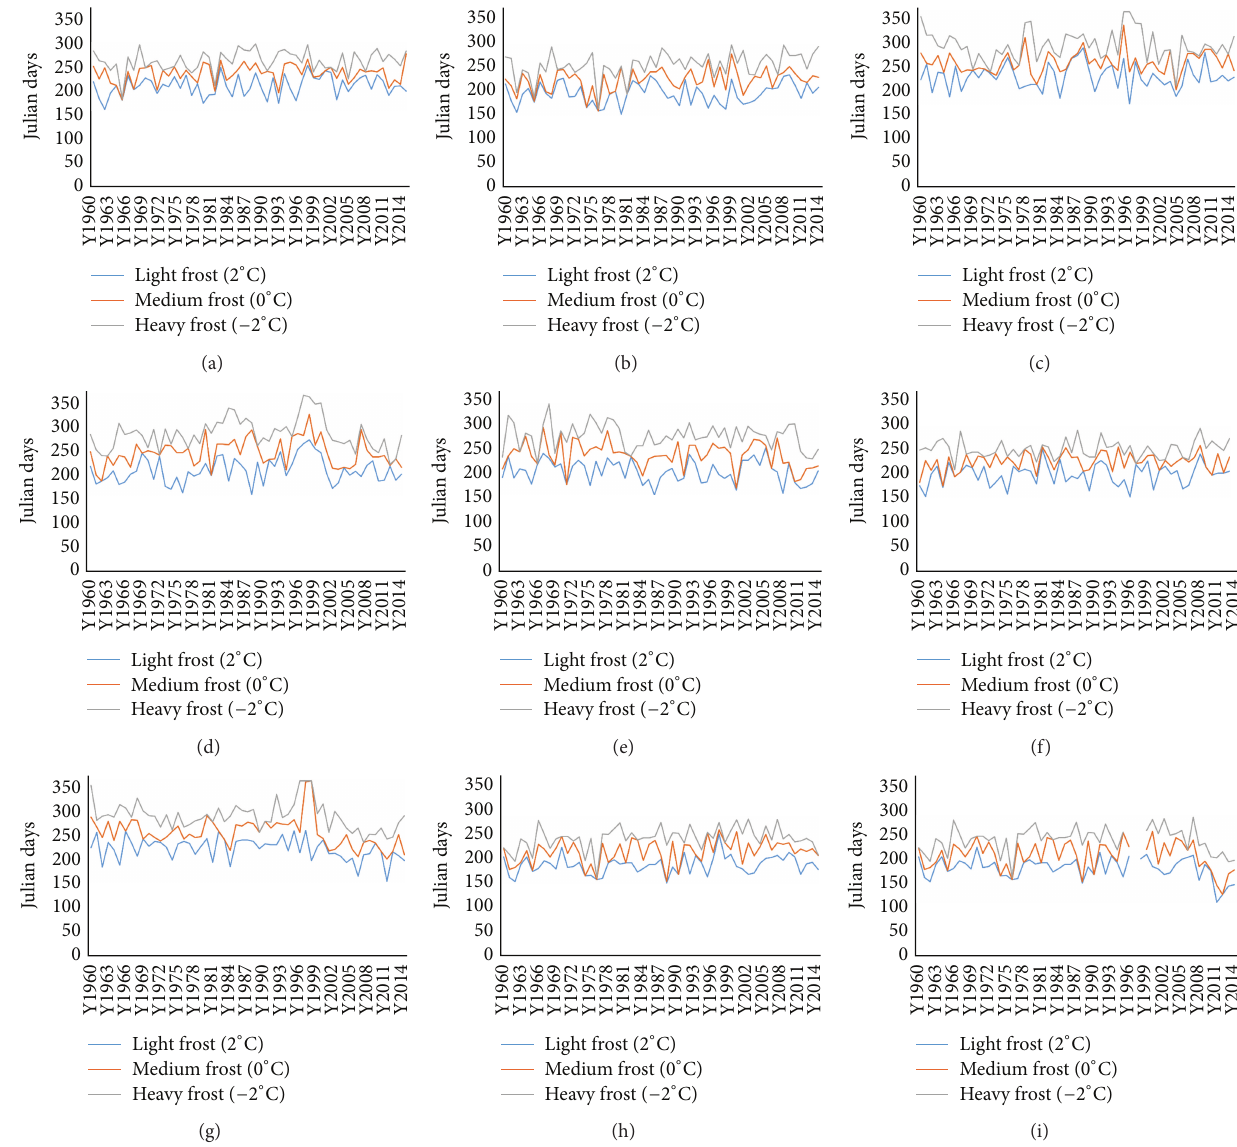
Figure 5: Time series of frost-free duration in days from 1960 to 2014 for (a) Bethlehem, (b) Bloemfontein, (c) Bothaville, (d) Fauresmith, (e) Ficksburg, (f) Frankfort, (g) Virginia, (h) Wepener, and (i) Zastron.